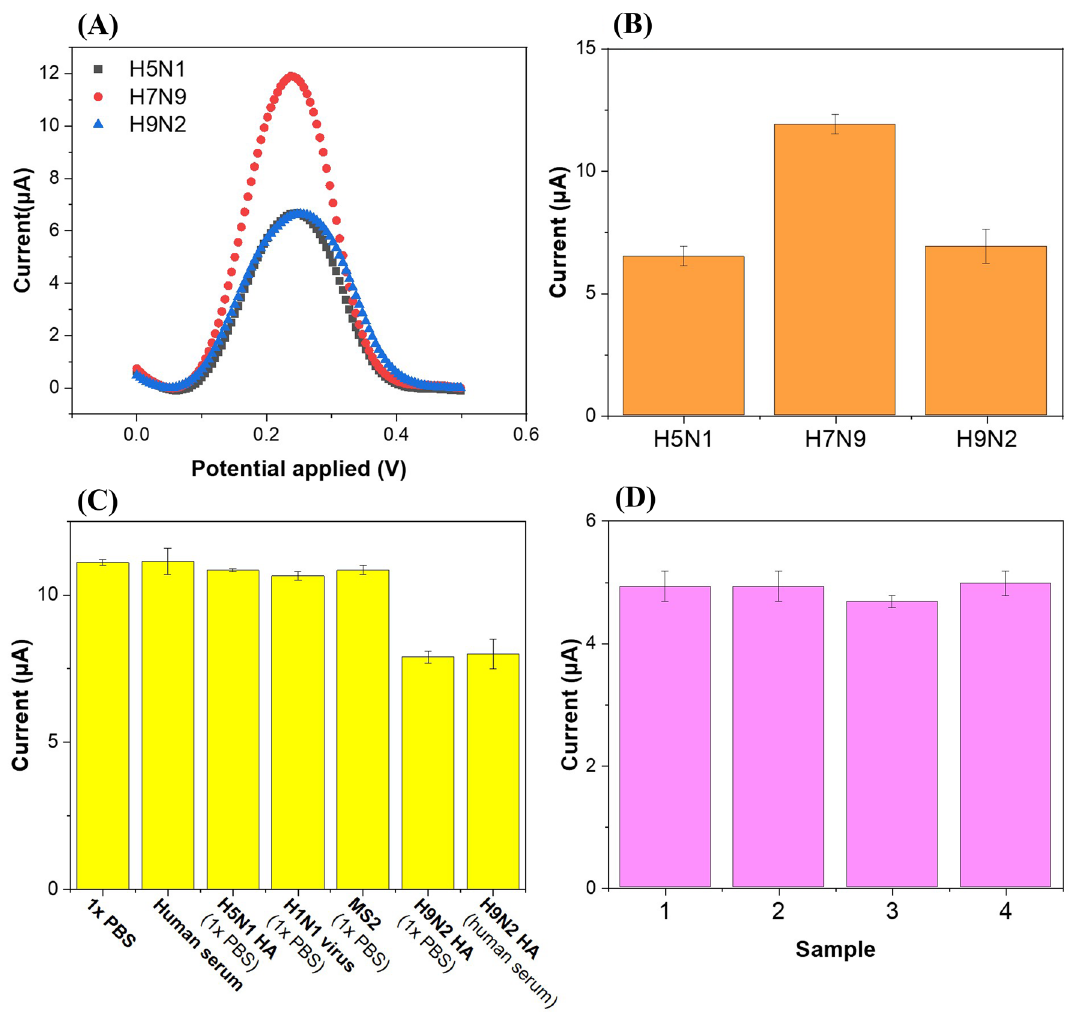
Figure 5. (A) Differential pulse voltammograms and (B) peak currents of three BSA/Ab/COOH-CNT/ CNT-PDMS electrodes of the proposed immunosensors after 10 µ l of 1 × PBS containing 10 ng/ml of H5N1 HA and 10 ng/ml of H9N2 HA was injected and incubated at room temperature for 30 min. (C) Selectivity of the immunosensors (H9N2-Ab functionalized electrodes) for influenza virus H9N2 hemagglutinin antigen detection. The test included 1 × PBS only, ten-fold diluted human serum only, non-targets (H5N1 HA, H1N1 virus, and MS2 bacteriophage) in 1 × PBS, and targets in 1 × PBS or ten-fold diluted human serum. (D) Reproducibility of the immunosensors (H5N1-Ab functionalized electrodes) using H5N1 HA antigen (concentration: 100 ng/ml). The error bars represent the standard deviations of three independent